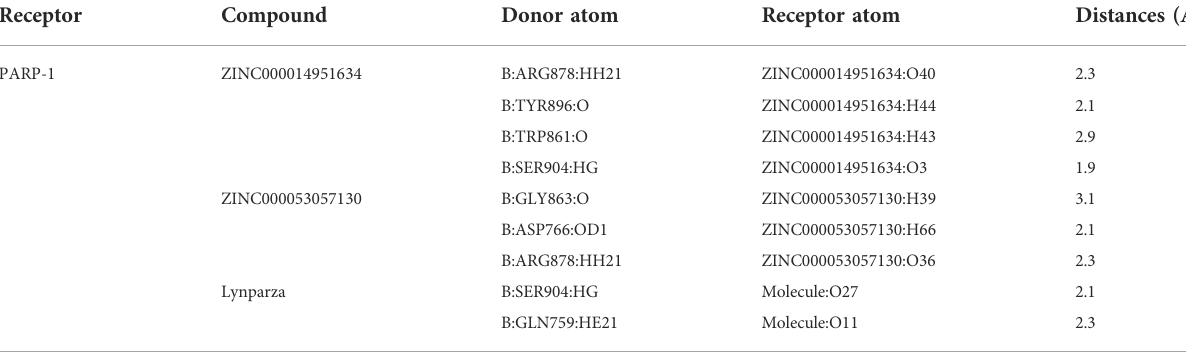
TABLE 5 Hydrogen bond interaction parameters for each compound and PARP-1 residues. Receptor Compound PARP-1